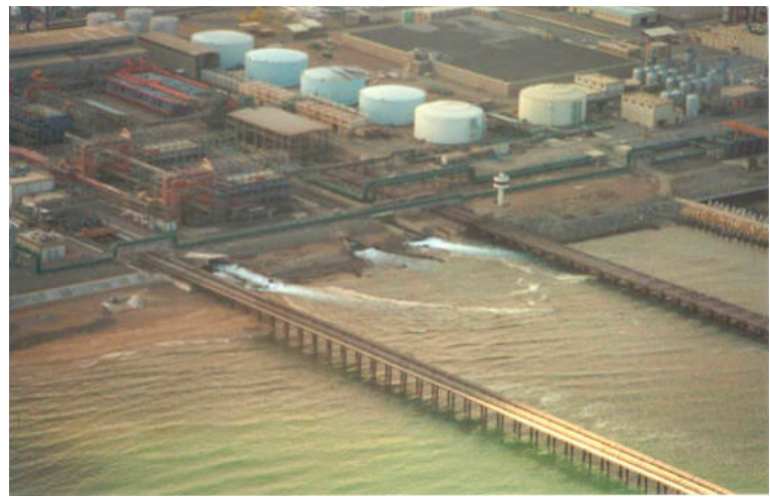
Figure 1. Surface discharge of the Al-Ghubrah desalination plant, the largest such facility in Oman (Source: H.H. Al-Barwani).